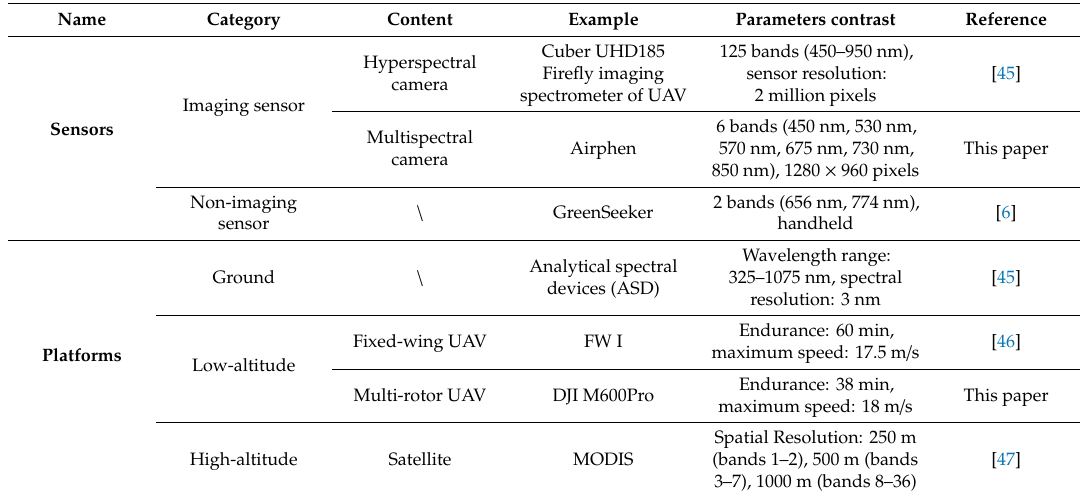
Table 6. Parameters comparison for di ff erent sensors and